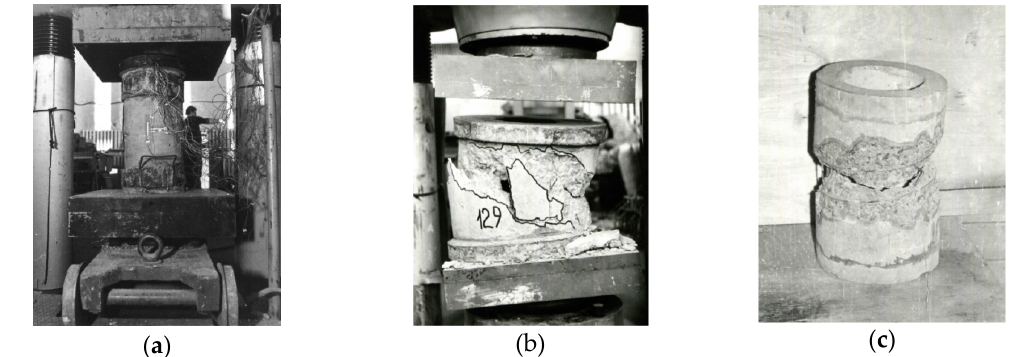
Figure 2. Specimens of centrifuged concrete (a) before and (b, c) after loading.